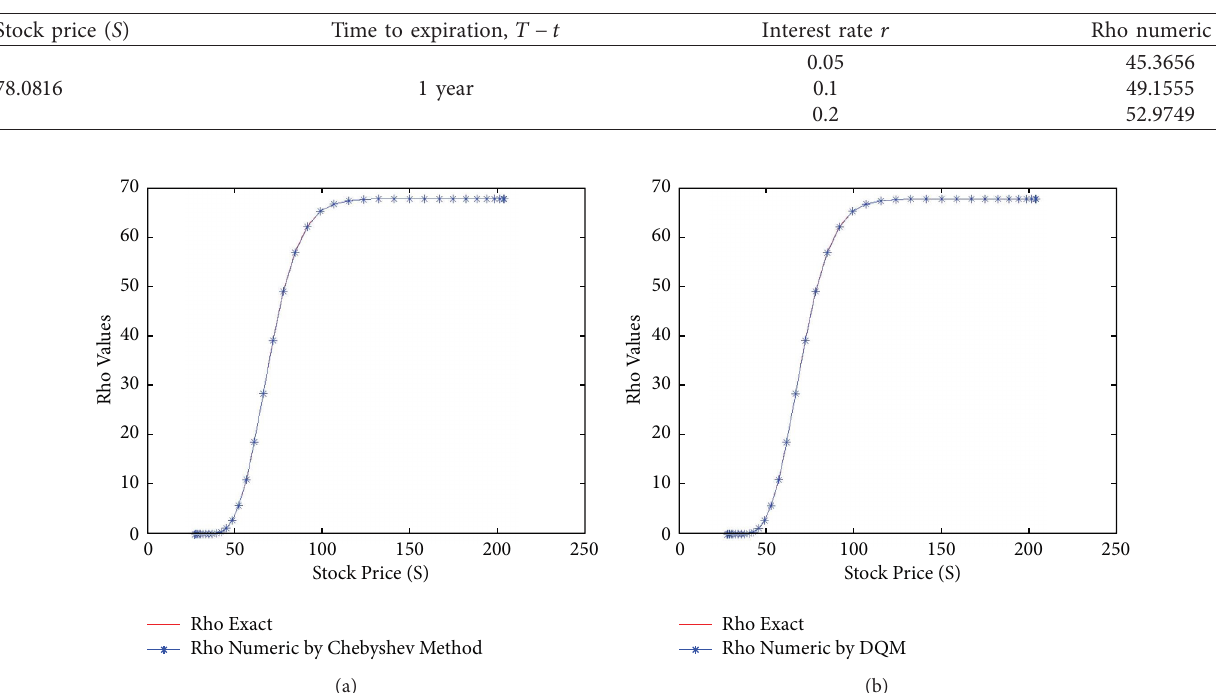
Figure 15: Sensitivity analysis (rho) by Chebyshev spectral method (a) and by differential quadrature method Table 4: Rho values for different interest rates.